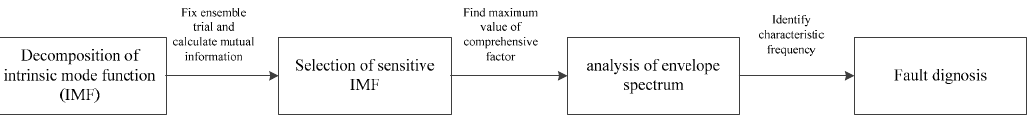
Figure 18. Flowchart of fault diagnosis.